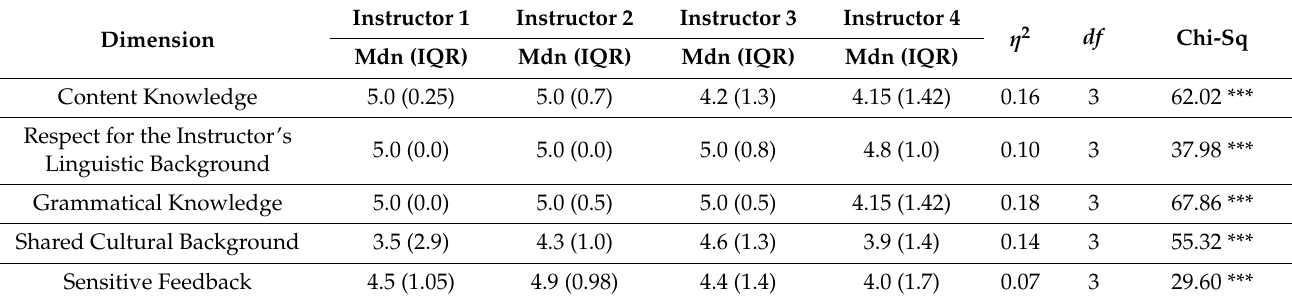
Table 2. Kruskal–Wallis non-parametric tests for ratings of instructor profiles.